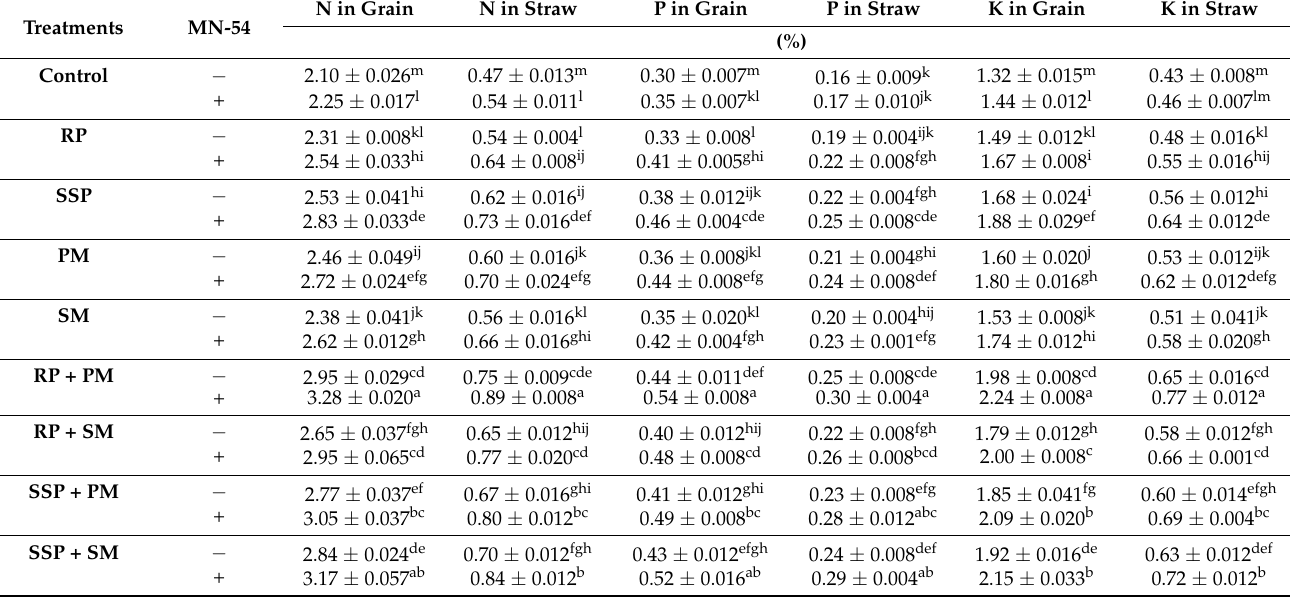
Table 4. Effect of phosphorus fertilizers, organic manures, and Bacillus sp. MN-54 addition on N, P, and K content in chickpea. Treatments MN-54